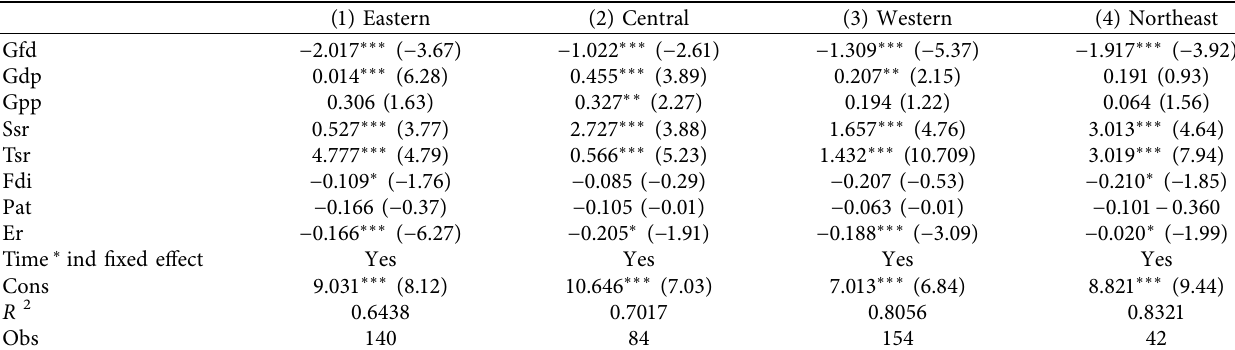
Table 4: Subregional regression results of benchmark